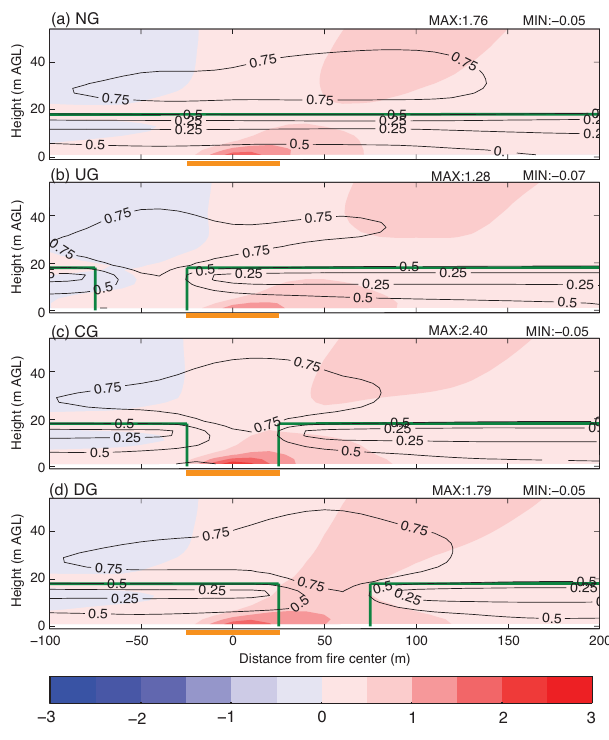
Figure 4. As in Fig. 2 but for TKE (m 2 s − 2 ); contour interval is